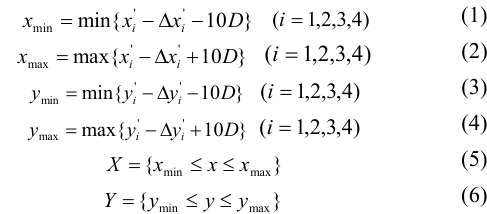
Figure 4. The calculation of discretization range. (a) Discretization range of source DEM; (b) Target block